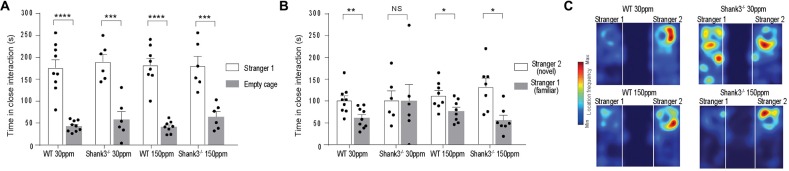
ASD social interaction deficits in Shank3ex13–16−/− mice are prevented by increased dietary zinc. (A) All mice display normal social interaction during phase two of the three-chamber test. (B)
Shank330 ppmex13−16−/− mice lack social novelty recognition during phase three, displaying no preference for the stranger or familiar mouse. Increased dietary zinc recovered the social novelty recognition behavior in Shank3ex13–16−/− mice. (C) Example heat maps of phase three of the social interaction test. WT mice on the normal and high zinc diet prefer the novel mouse as depicted by increased presence close to stranger 2. Shank3ex13–16−/− mice on the normal zinc diet show no preference for the novel mouse (stranger 2), but do show increased interaction with the novel mouse when fed the high zinc diet. All data represent mean ± SEM, two-tailed paired t-test. WT30 ppm
n = 9, Shank330 ppmex13−16−/−
n = 6, WT150 ppm
n = 8, Shank3150 ppmex13−16−/−
n = 7 mice. *p < 0.05, **p < 0.01, ***p < 0.001, ****p < 0.0001, NS, not significant.